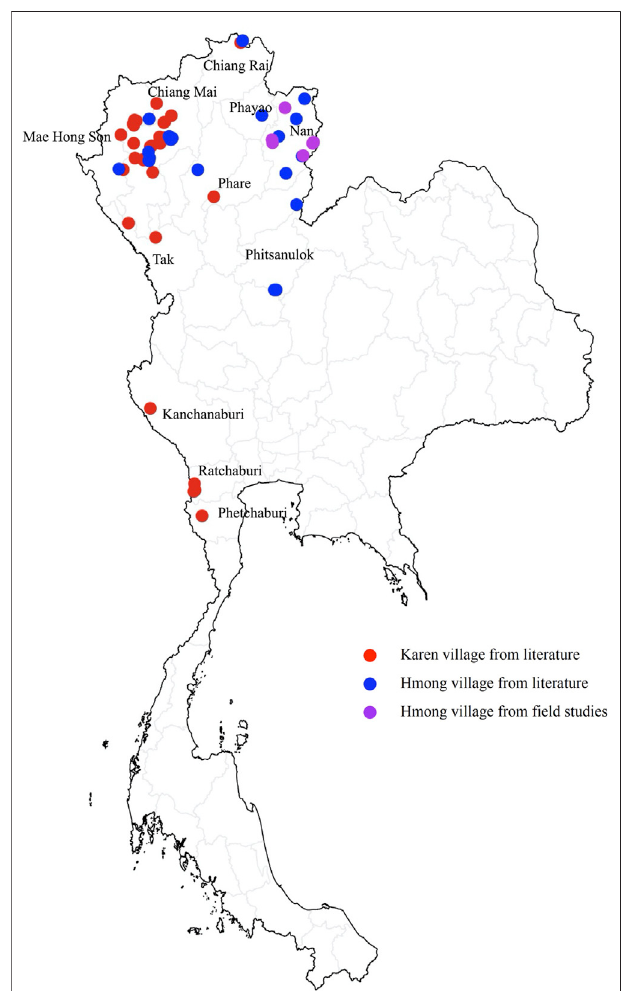
FIGURE 1 | Locations of 56 Thai Hmong and Karen villages providing ethnomedicinal plant knowledge for treatments of symptoms related to mild Covid-19 symptoms in this